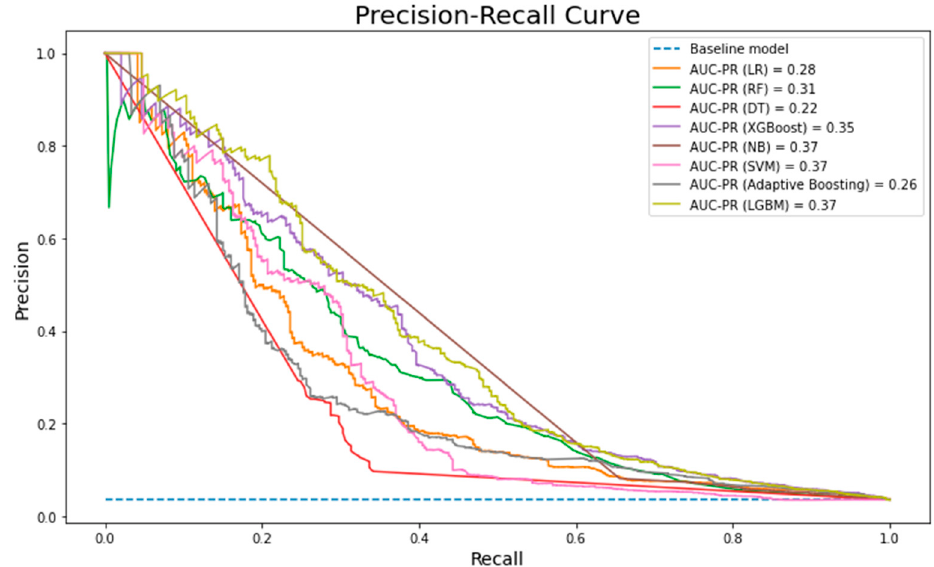
Figure 8. AUC-PR of the single models. Table 3. Adaboost confusion matrix.